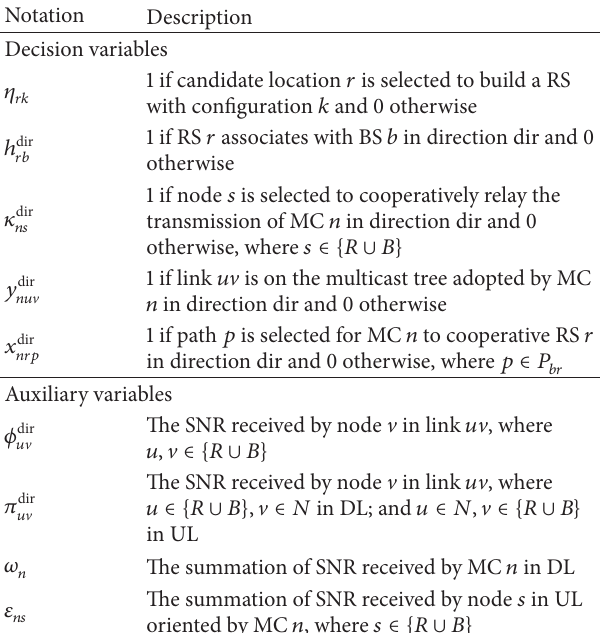
Table 2: Notations of decision